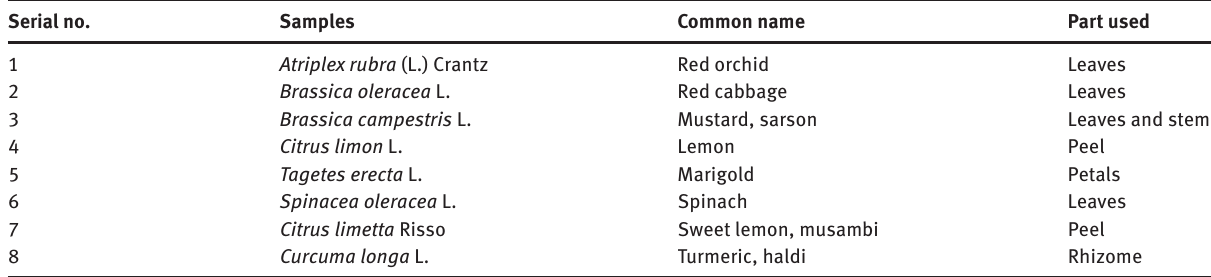
Table 1: Plant materials used for color extraction. Serial